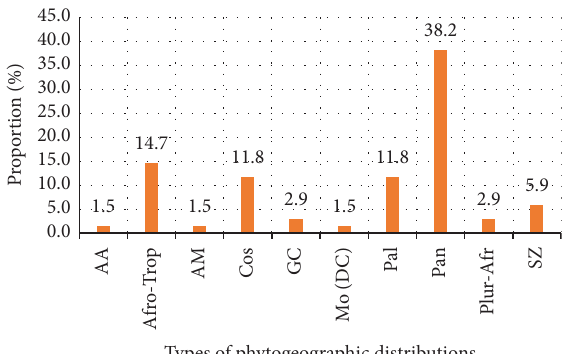
Figure 9: Proportion of phytogeographic distribution types: (AA) African, (Afro-Trop) Afro-Tropical, (AM) Afro-Malagasy, (Cos) Cosmopolitan, (GC) Guineo-Congolese, (Mo) Montane, (Pal) Paleotropical, (Pan) Pantropical, (Plur-African) Pluriregional African, and (SZ)